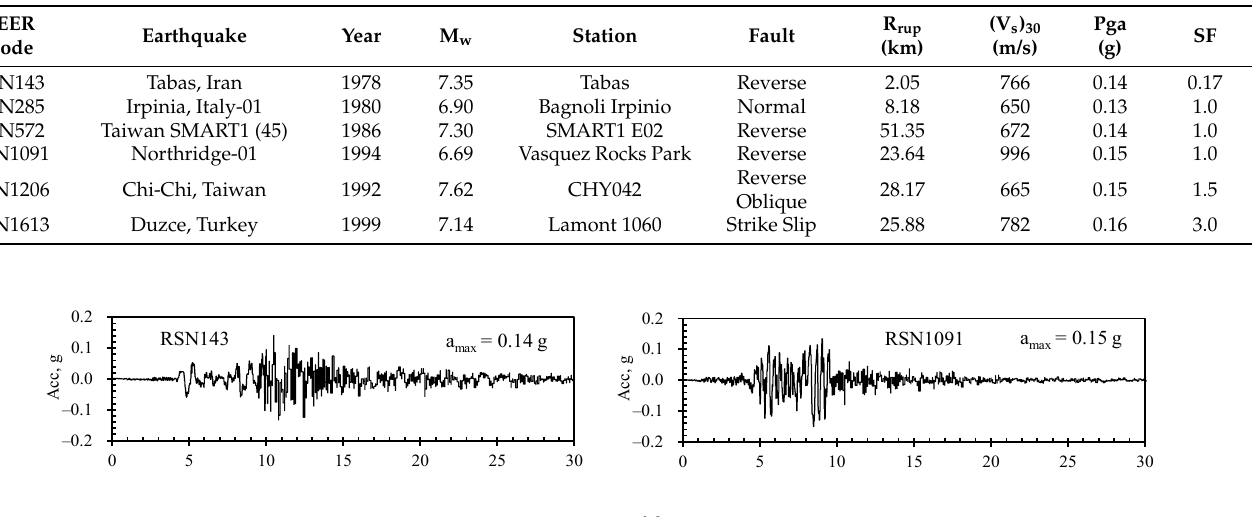
Table 5. The earthquake records used in the soil–pile–structure interaction analyses.